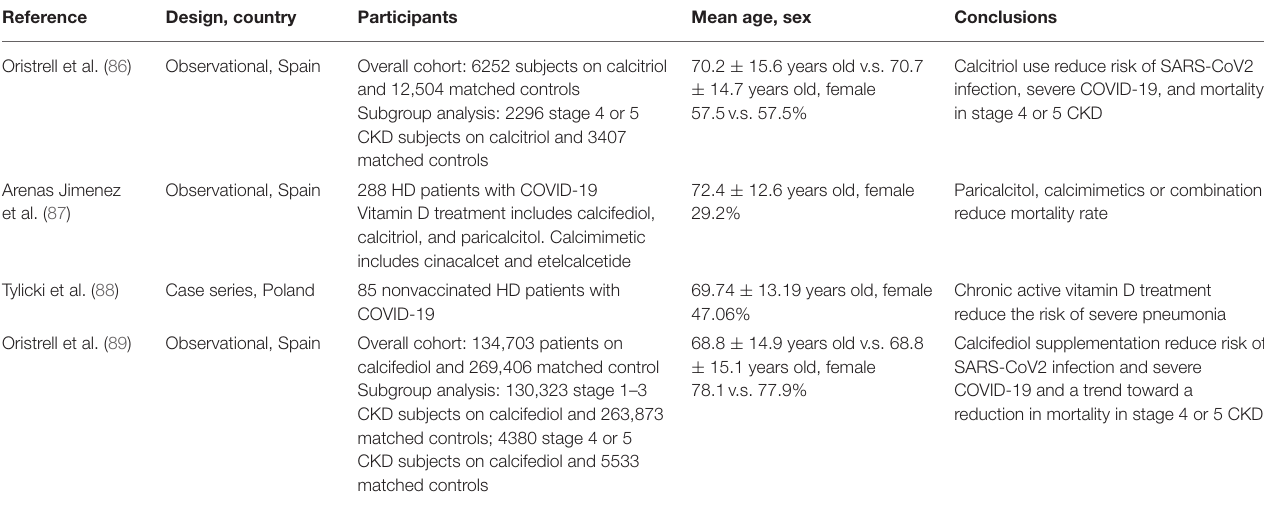
TABLE 1 | Clinical studies evaluating vitamin D effects on COVID-19 in CKD